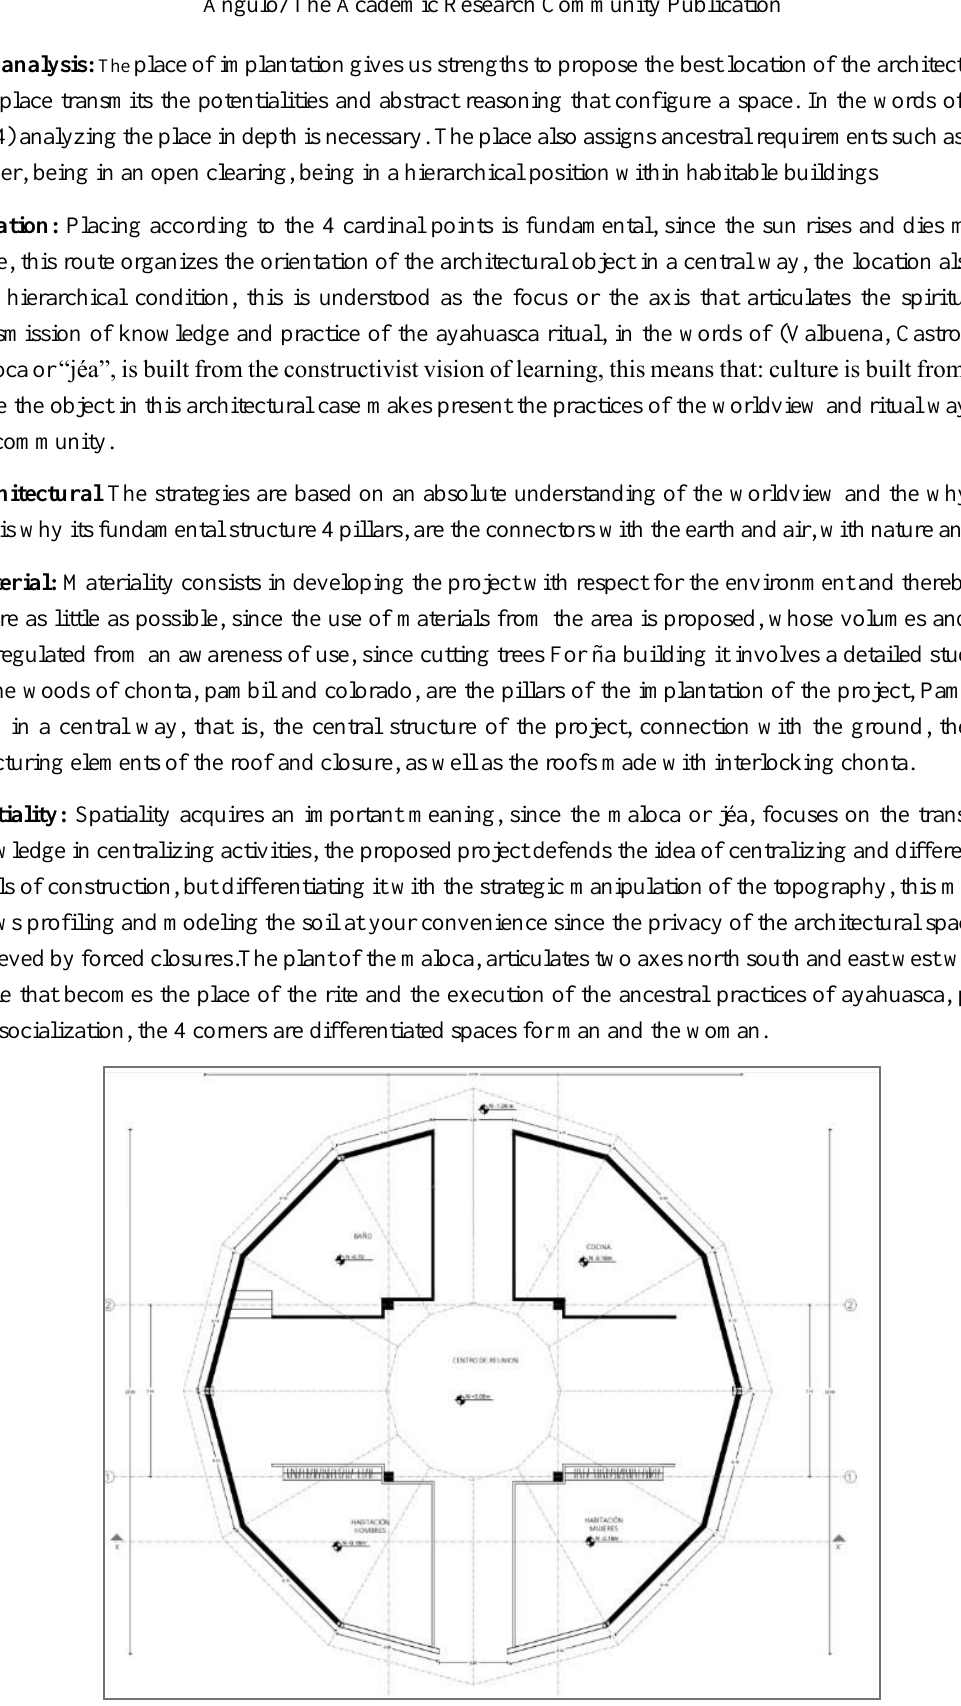
Figure 2. Malocas Single Floor Design: Huaraca, Diego